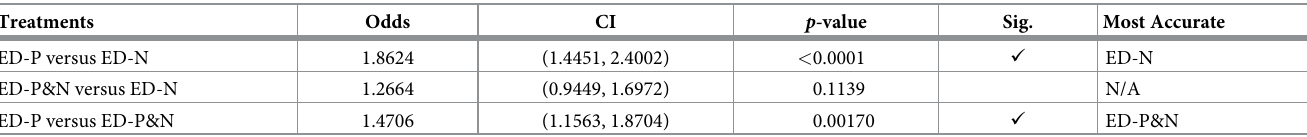
Table 7. ED : Intersection cardinality accuracy analysis. Treatments